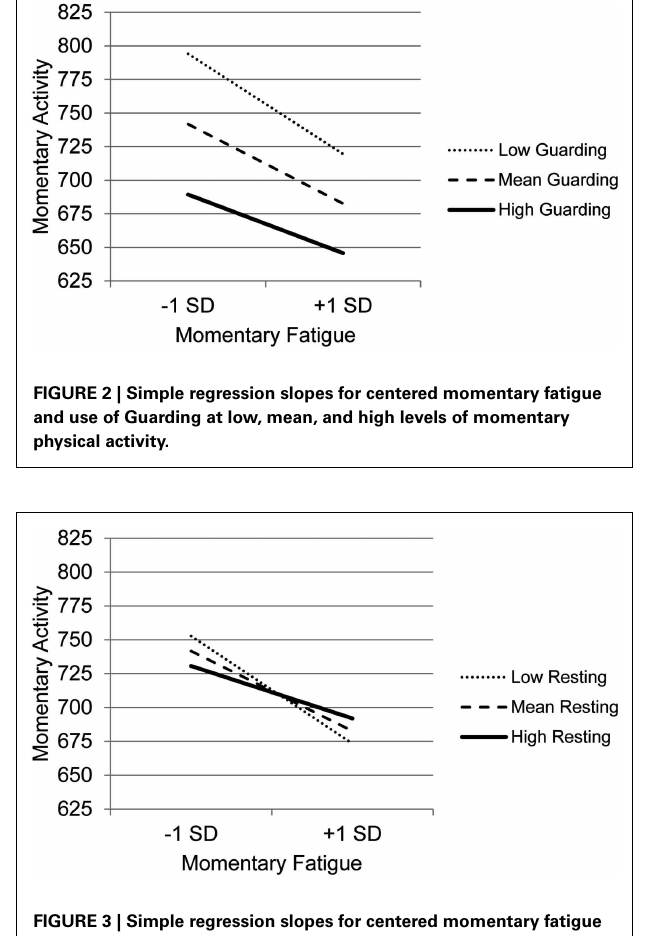
FIGURE 5 | Simple regression slopes for centered momentary fatigue and use of Pacing at low, mean, and high levels of momentary physical